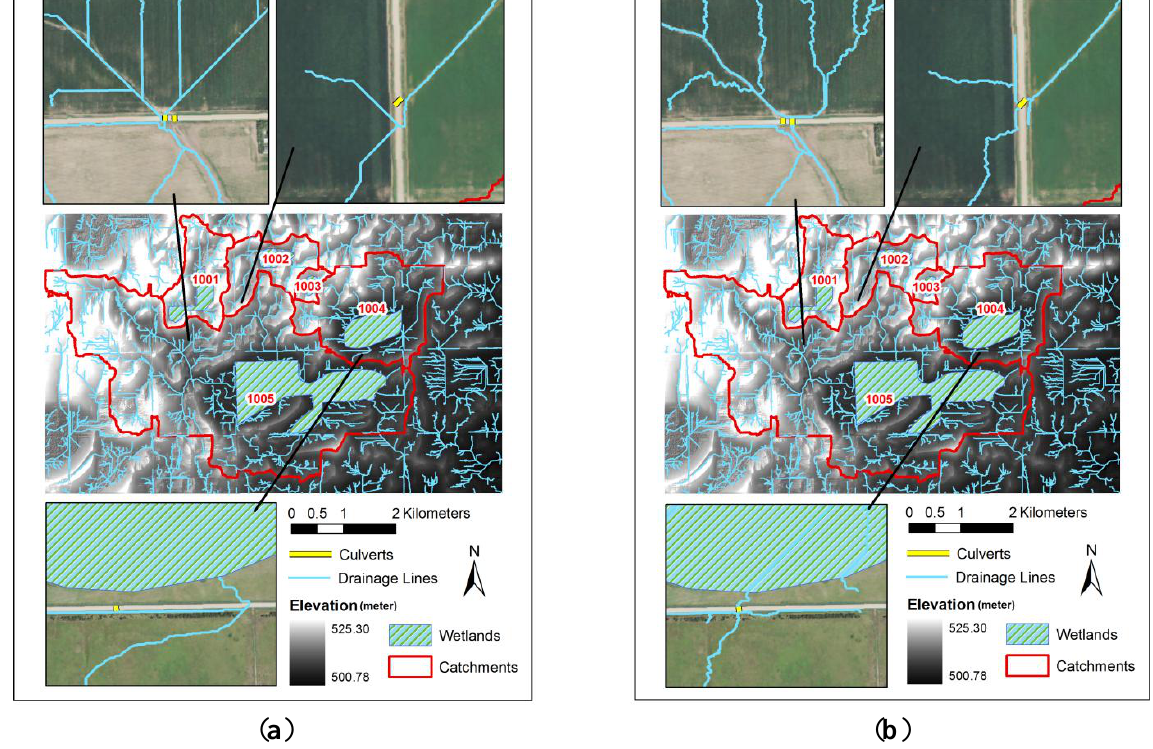
Figure 4. Simulated catchments and drainage lines for Modeling Area 1. ( a ) Did not incorporate culvert information, and ( b ) incorporated culvert information in modeling.